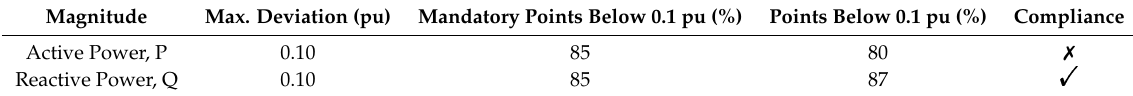
Table 5. Verification of the PVVC validation criteria applied to the IEC generic WT model at the low voltage side, operating at full load conditions: 690 V, measurement point